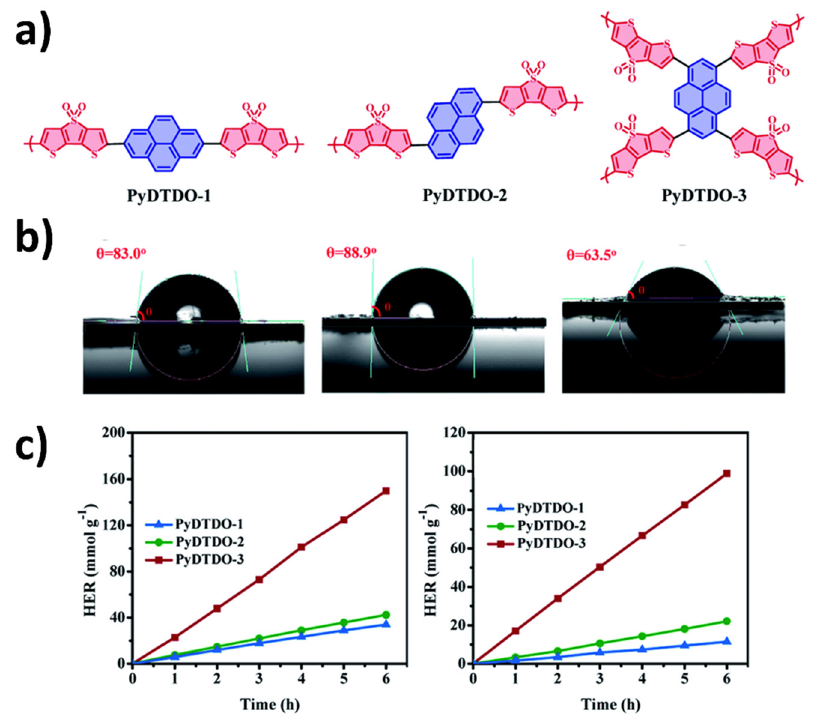
Figure 9. ( a ) Structures of PyDTDO-1, PyDTDO-2, and PyDTDO-3; ( b ) Contact angles of PyDTDO-1, PyDTDO-2, and PyDTDO-3 against water; ( c ) Sacrificial photocatalytic hydrogen evolution of the polymer photocatalysts broadband irradiation (left, λ > 300 nm), and visible light irradiation (right, λ > 420 nm) [Figure adapted from ref. [82] under CC-BY 3.0 International License]. Small polar side-group functionalization has also been explored as a strategy for en- hancing wettability. Benzodiimidazole based oligomers with varying amounts of carboxyl substituents were synthesized using suitable monomers in a condensation reaction. This led to the organic semiconductors having increased polarity and short-range crystallinity. The enhancement of wettability and photophysical processes resulted in efficient photo- catalytic hydrogen evolution with a rate of 18.63 mmol g − 1 h − 1 (4 wt% Pt cocatalyst, 0.2 M ascorbic acid as a hole scavenger and broadband irradiation) [84]. Post-synthetic modification has also shown potential: Copolymers of 4,8-bis(5-(2- ethylhexyl)thiophen-2-yl)benzo [1,2- b :4,5- b’ ]dithiophene and dibenzo[ b , d ]thiophene sul- fone building blocks were tuned by increasing the oxidation state of the thiophene units of the former to investigate the effect on photocatalytic hydrogen evolution [85]. The partially oxidized PBDTTS-1SO showed a high sacrificial hydrogen evolution rate under AM1.5g irradiation (97.12 mmol g − 1 h − 1 ) and a high EQE of 18.5% at 500 nm. While the most wettable polymer is not the best performing material, this is nevertheless an interesting approach to increase the wetting of polymer photocatalysts. Triazines as a nitrogen-containing class of heterocycles have been extensively studied in so-called ‘triazine-based frameworks’ (CTFs)[9,29,62,86]. The materials are intrinsically more wettable due to the polarity of the triazine group and materials with very high ac- tivity have been reported. Nevertheless, the dispersibility of CTFs is still variable when studying a set of materials as the wettability is varied, which has a strong and significant impact on the photocatalytic hydrogen production efficiency. Thus, CTFs with suitable band structure and good dispersibility are more likely to achieve higher photocatalytic hydrogen production rates [9]. For studies of sacrificial hydrogen production from water, organic scavengers such as diethylamine [1], triethylamine [56], triethanolamine [2], and or co-solvents, such as methanol [56] or N , N -dimethylformamide [82] are often used. These organic solvents are